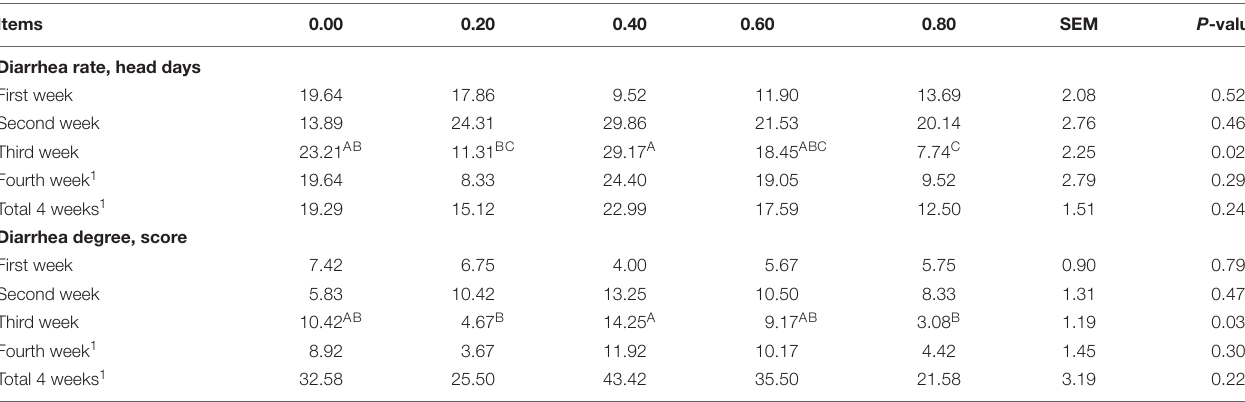
TABLE 3 | Effect of DAR on diarrhea occurrence of weaned piglets challenged with E. coli LPS. Items